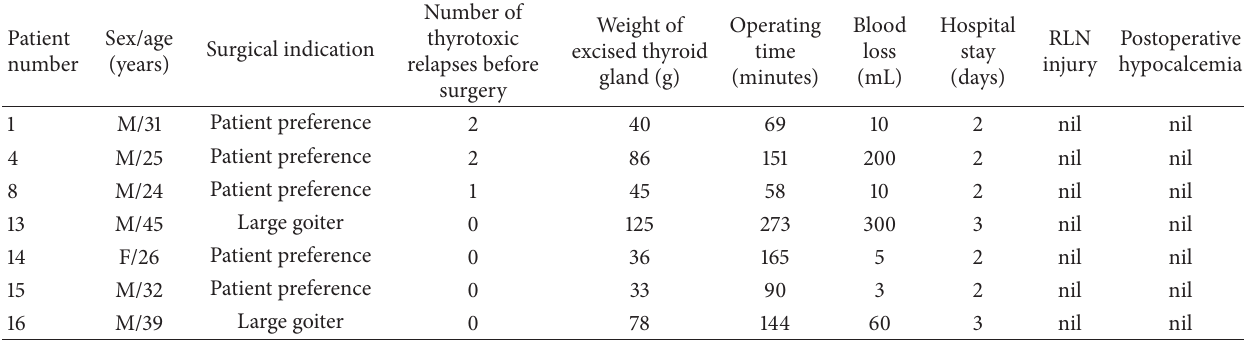
Table 4: Details of the 7 patients with thyrotoxic periodic paralysis who eventually underwent surgery/total thyroidectomy. Patient